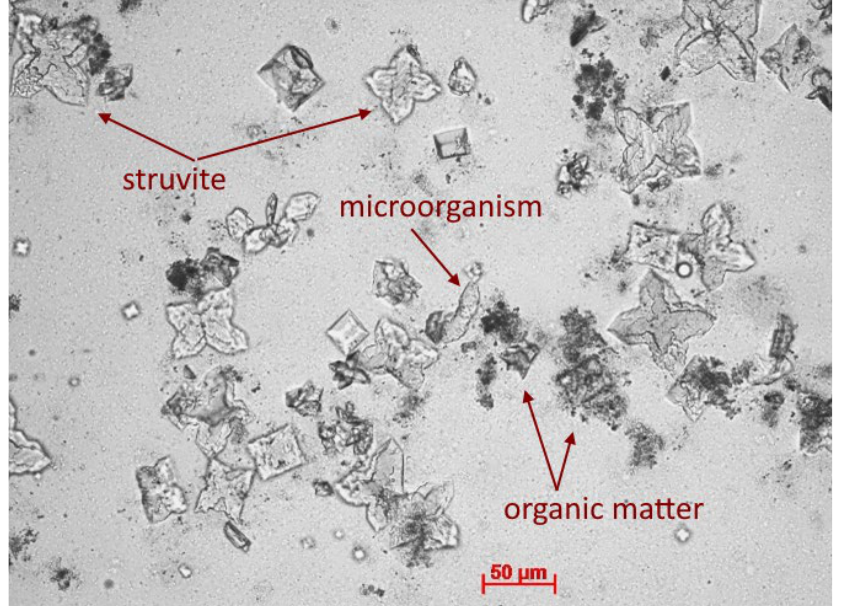
Figure 3. SEM images of sediment after struvite precipitation at a molar ratio of 5.13:1:1 from municipal liquid digestate.